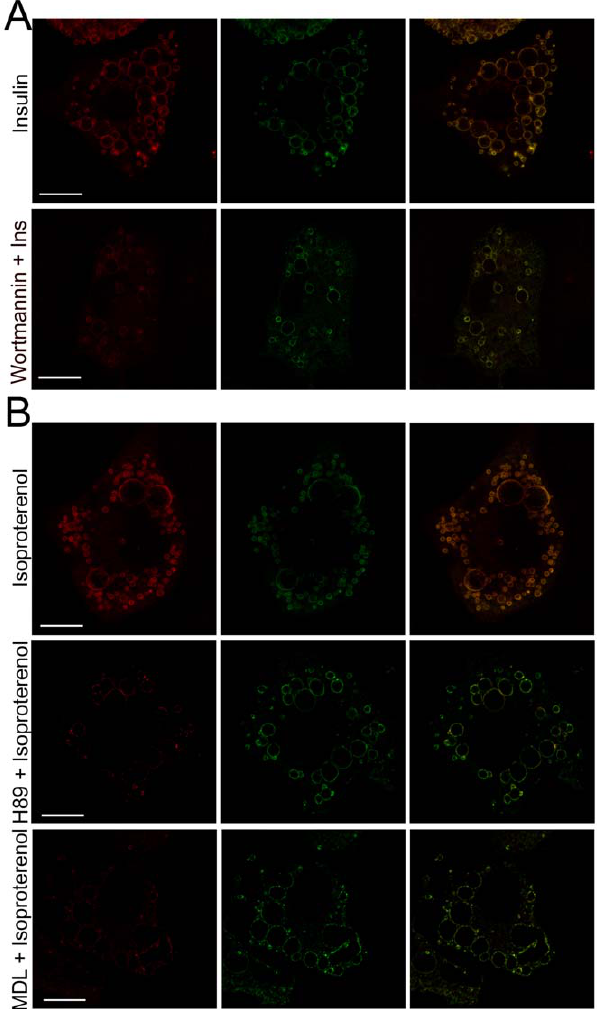
Figure 4. Intracellular signaling pathways mediating the effect of insulin and isoproterenol on Rab18 association with LDs. (A) Representative confocal images of 3T3-L1 adipocytes treated with 100 nM insulin for 4 h in the absence (top panels) or presence of the PI3K blocker wortmannin (1 m M). (B) Representative confocal images of 3T3-L1 adipocytes treated with 10 m M isoproterenol for 4 h in the absence (top panels) or presence of the PKA blocker H89 (1 m M; middle panels) or the adenylate cyclase blocker MDL 12,330 (1 m M; bottom panels). After treatment, cells were co-immunostained for Rab18 (red) and perilipin (green). Colocalization of the two proteins is shown in the images on the far right (yellow). Scale bars, 5 m m.